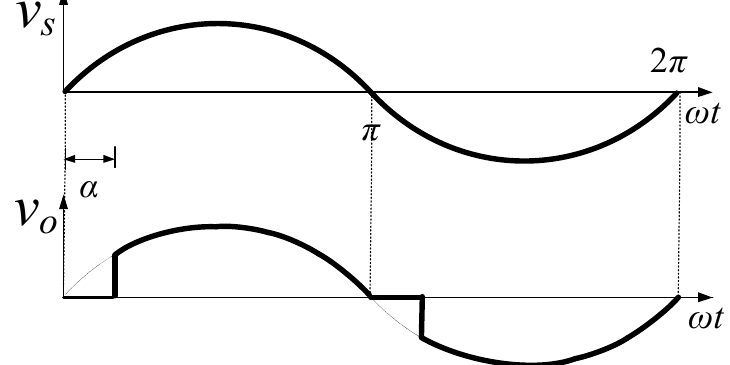
Figure 3. Output RMS voltage control through bipolar phase-angle control.